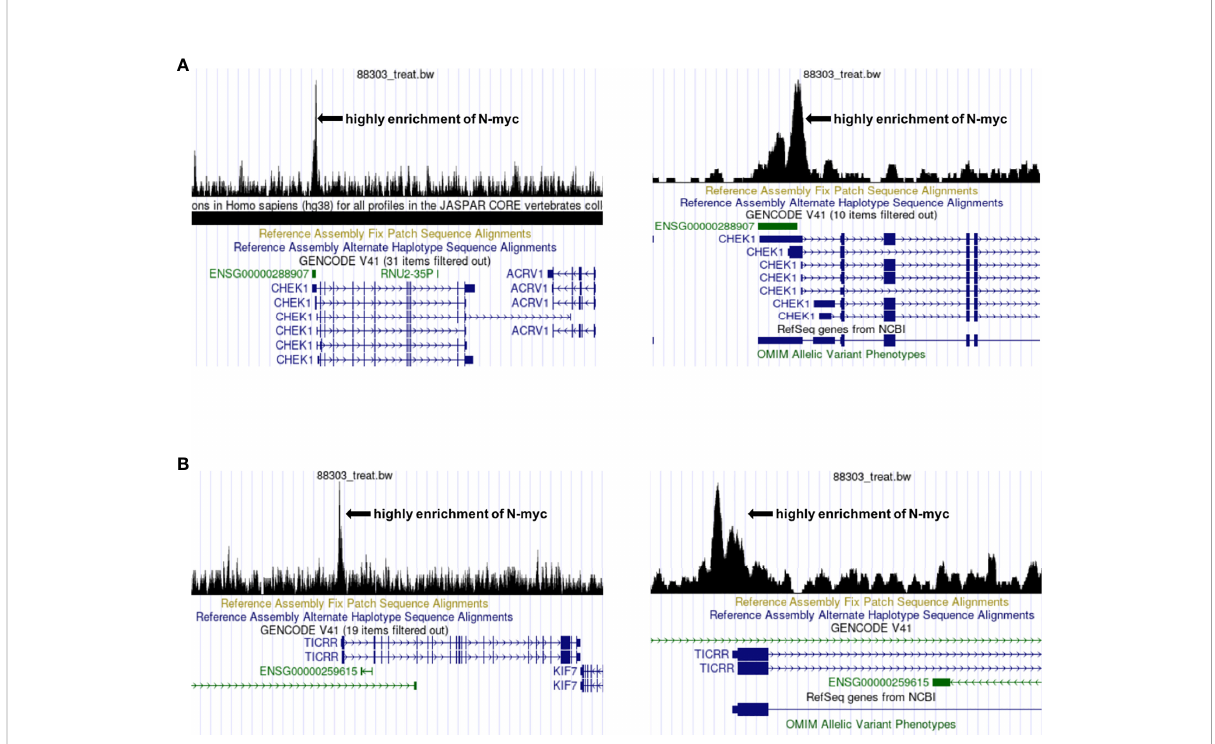
FIGURE 10 Prediction of the correlation between CHEK1 , C15ORF42 and MYCN (A) The UCSC database predicts that N-myc is highly enriched near the CHEK1 transcription start site. (B) The UCSC database predicts that N-myc is highly enriched near the C15ORF42 transcription start